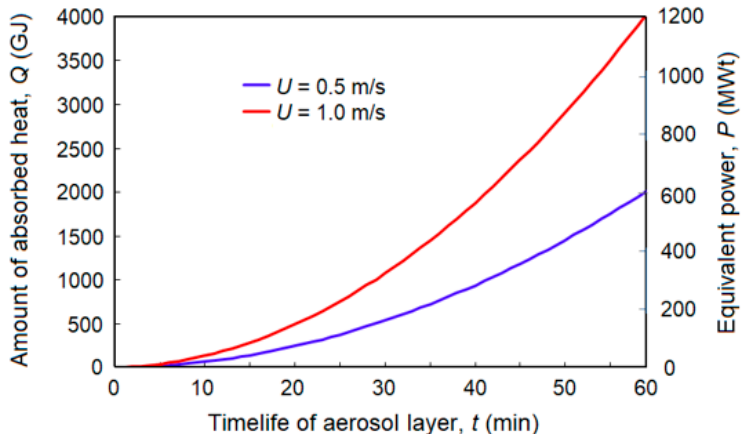
Figure 4. Time course of the amount of solar radiation heat Q (GJ) that can be absorbed by the aerosol layer created by five continuous aerosol sources and the equivalent power of the solar meteotron P (MWt). at surface wind speeds of 0.5 and 1.0 m/s.